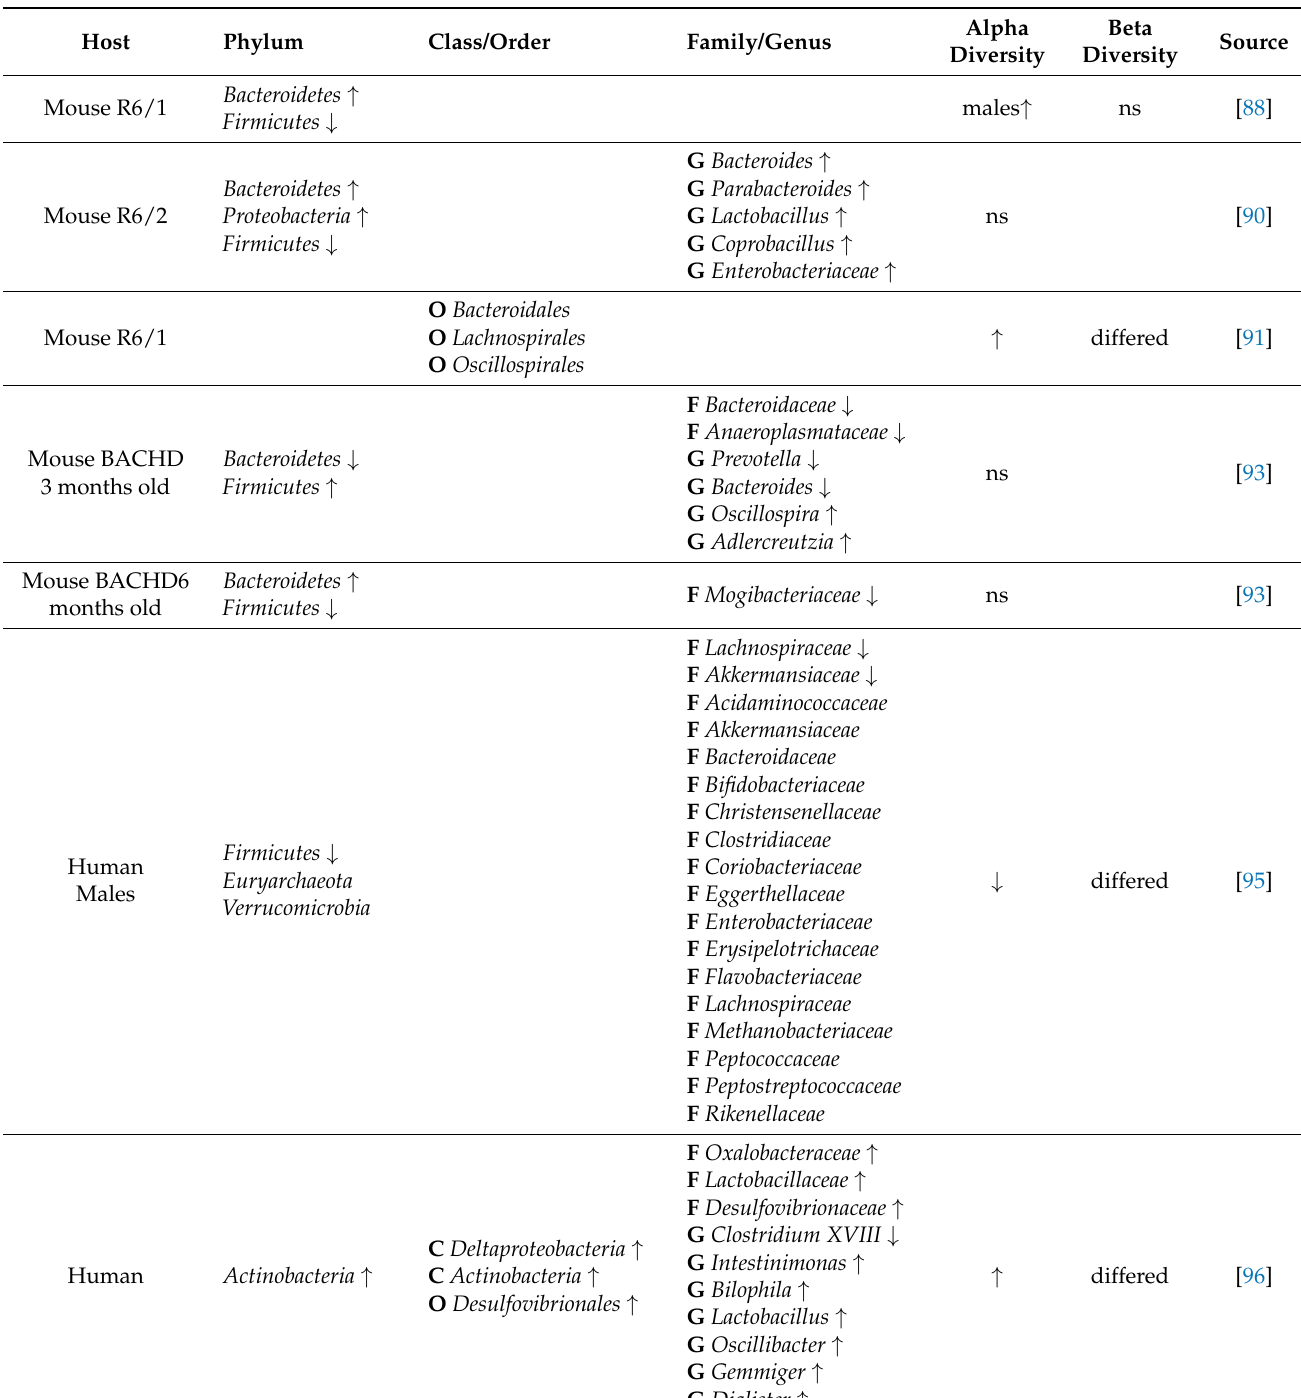
Table 1. Summarized results of microbiome studies performed in HD mouse models and HD patients. The table shows bacterial species changed in HD, ↑ signifies increase, ↓ signifies decrease. C – Class, O – Order, F – Family, G –